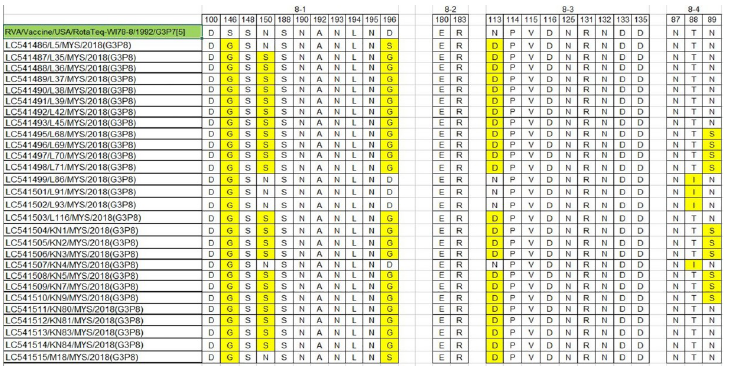
Fig 10. Comparison of the antigenic residues of VP4 present in genotype G3 strains of RotaTeq and the strains circulating in Sabah, Malaysia. The respective antigenic epitopes are shown above the residue numbers. The amino acid residues in the Sabahan strains that differed from those in the vaccine strains are highlighted in